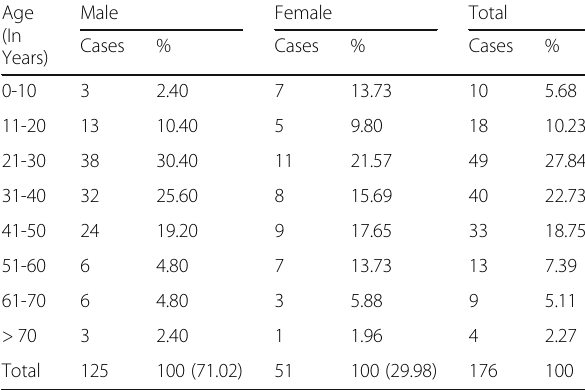
Table 1 Age and Gender distribution of drowning deaths